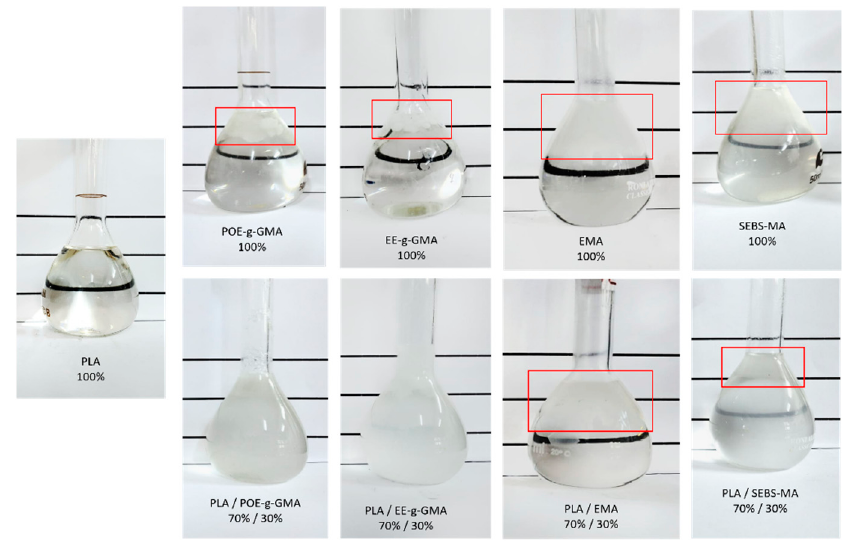
Figure 3. Dissolution of pure PLA, impact modifiers and blends (70/30%) in NMP